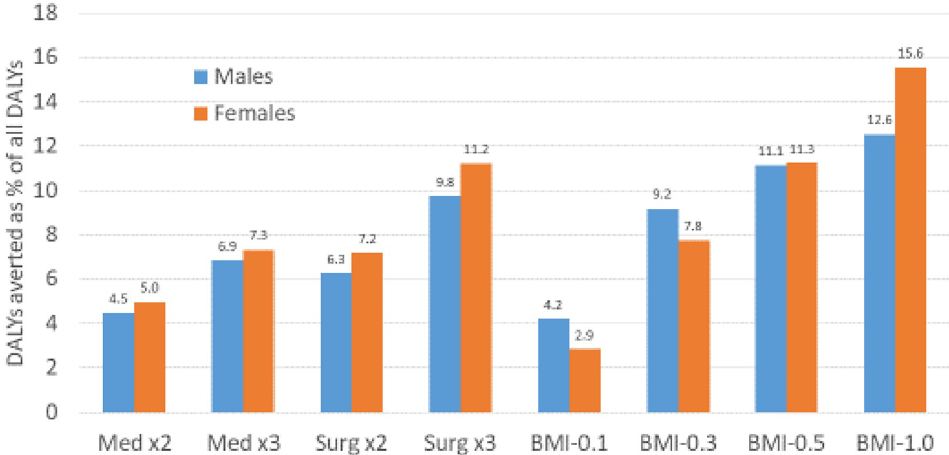
Fig 6. DALYs averted due to 8 interventions as a percentage of all OA-related DALYs, relative to base-case, over an 80-year time horizon. DALYs, disability-adjusted life years. OA, osteoarthritis. All interventions are described